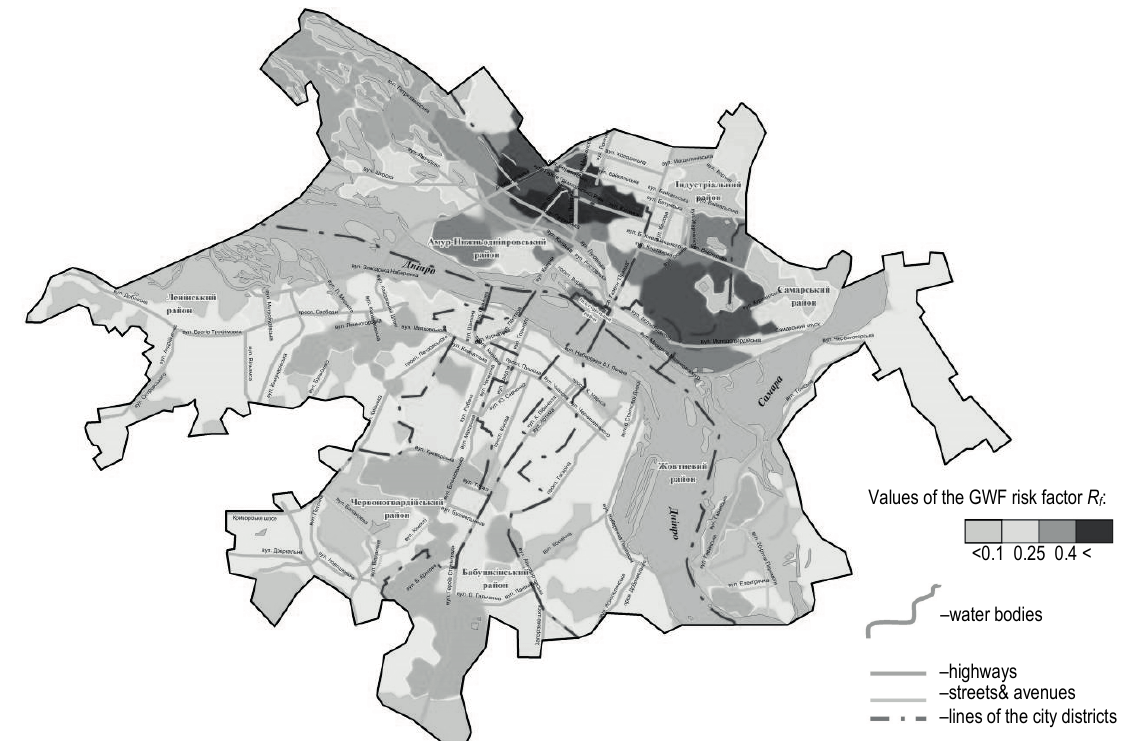
Fig. 1 Zoning GWF risk for Dnipropetrovsk